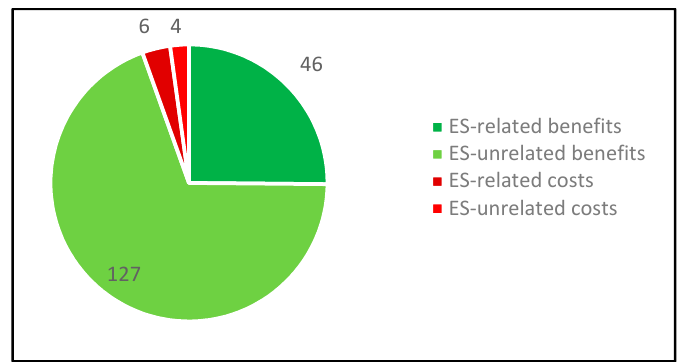
Figure 8. Overall frequency of references relating to social benefits and costs in the Cartagena case study (own representation).